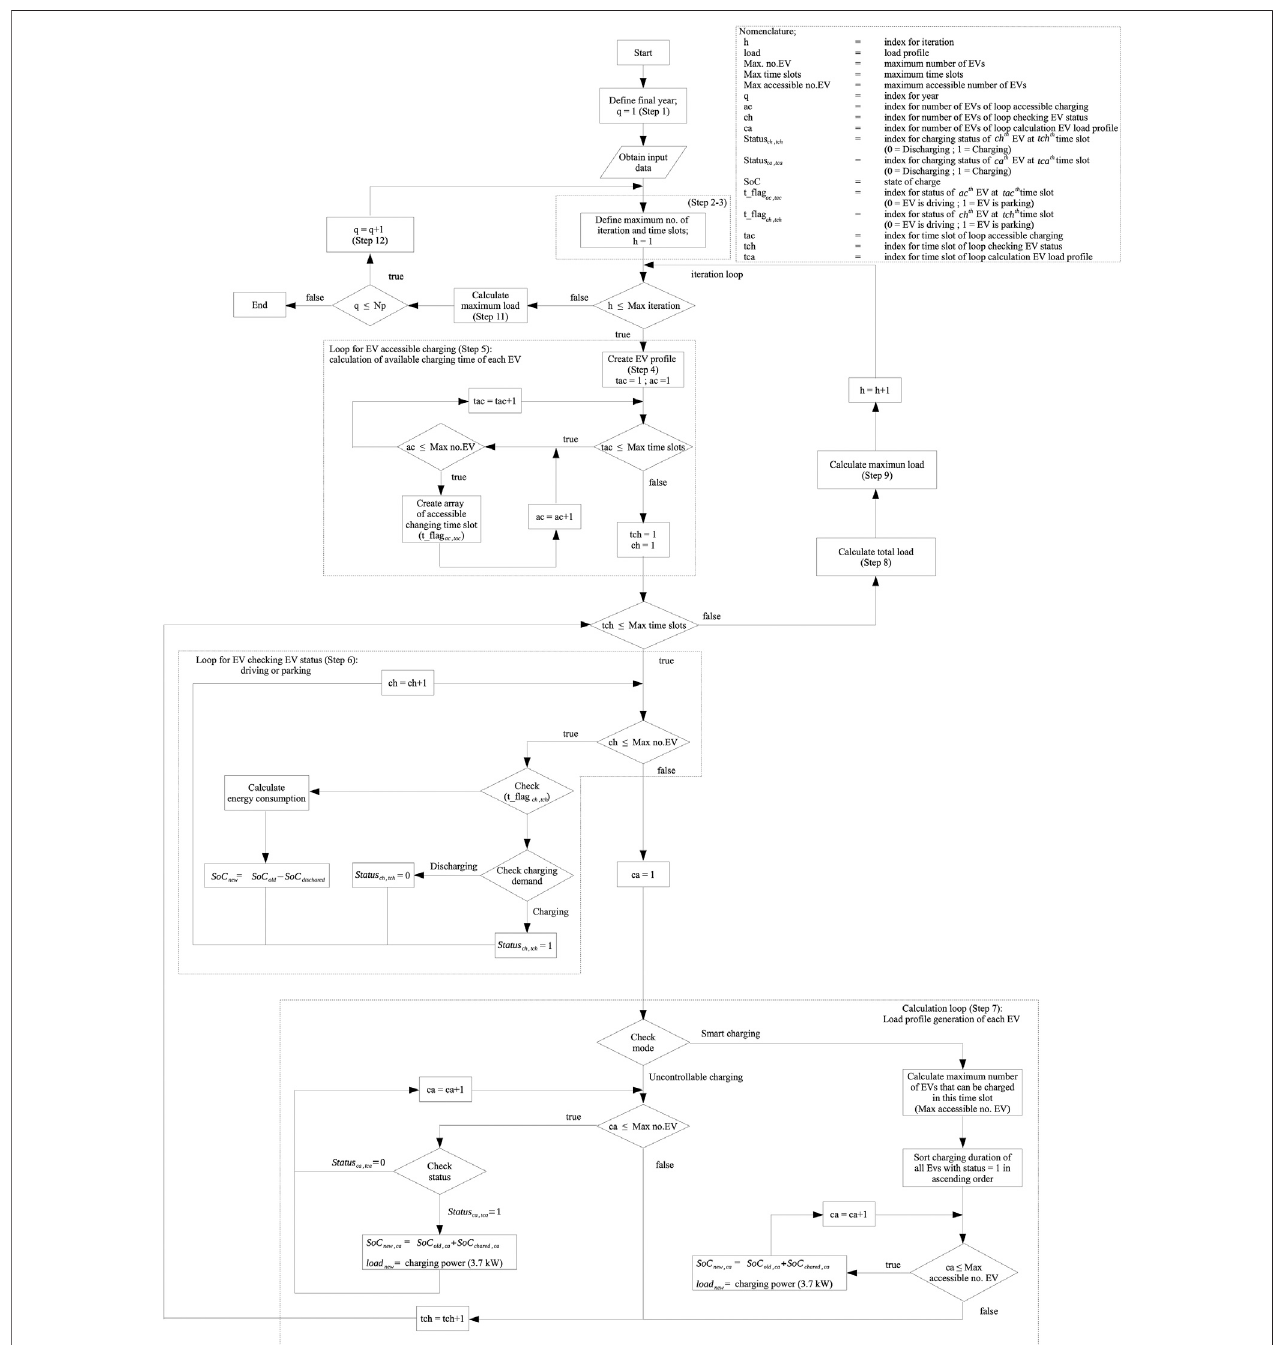
FIGURE 2 | Detail of activity-based EV load pro fi le simulation.